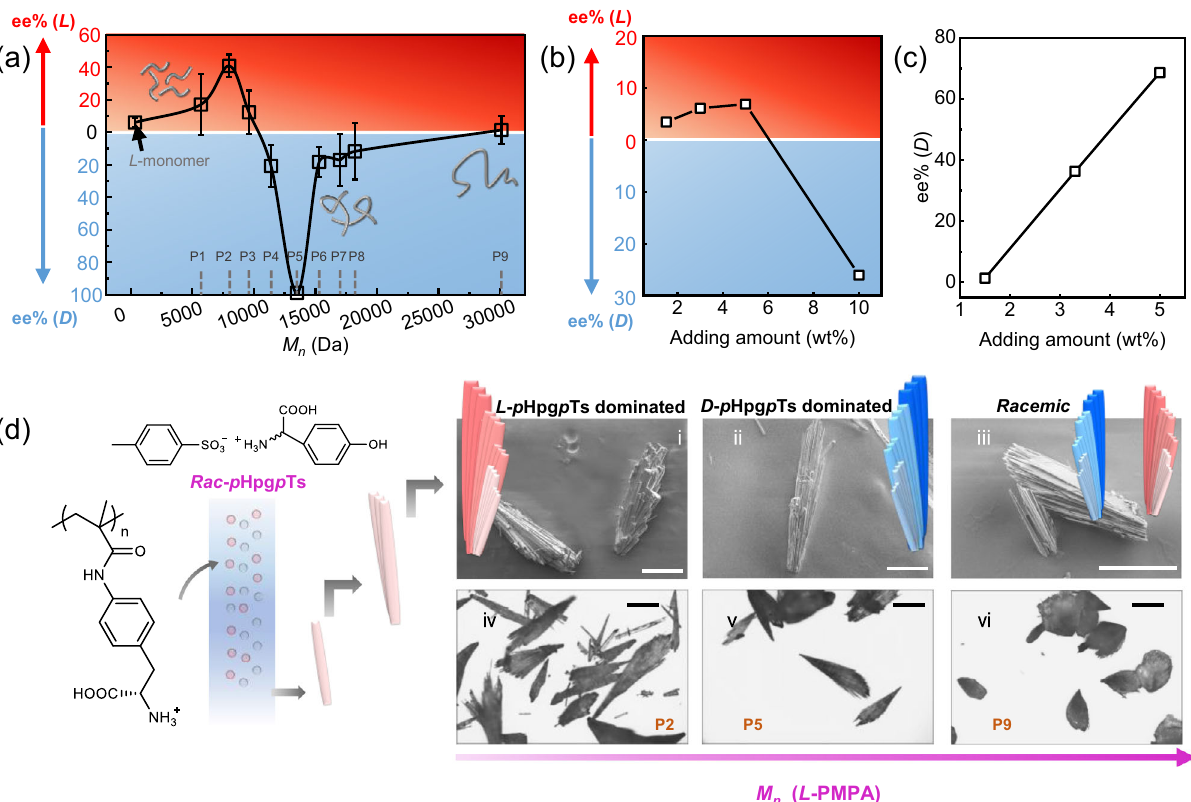
Fig. 3 Chirality tuning by using polymeric additives with various molar masses. a The ee% values of the obtained crystals by using L -monomer or L - polymers with various molar masses as additives. Error bars are standard errors calculated from fi ve independent experiments. b The ee% values of the obtained crystals by using different amount of L -monomers. c The ee% values of the obtained crystals by using different amount of P9. d The hierarchically ordered crystals were generated from racemic solutions and their inner and apparent chirality can be tuned by changing additives ’ molar masses: (iv – vi) Optical micrographs of the crystals obtained by using polymers with different M n s (8000, 13500 and 30100 Da) as additives. (i – iii) the corresponding partially enlarged SEM images, showing the detailed morphologies of the fan-shaped crystals. Scale bar: 200 μ